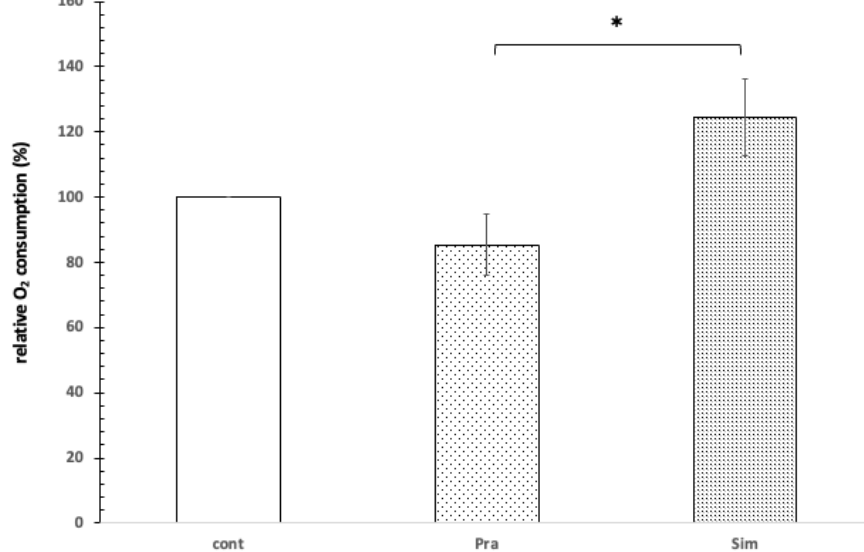
Figure 4. The effect of pravastatin and simvastatin on the oxygen consumption of rat liver mito- chondria. Control without pravastatin and simvastatin (cont), 100 μ M pravastatin (Pra), 100 μ M simvastatin (Sim), 1 mM Mg 2+ , 1 mM GSH, 1 mg protein/mL, pH = 8.0, T = 37 °C. * shows significant difference.